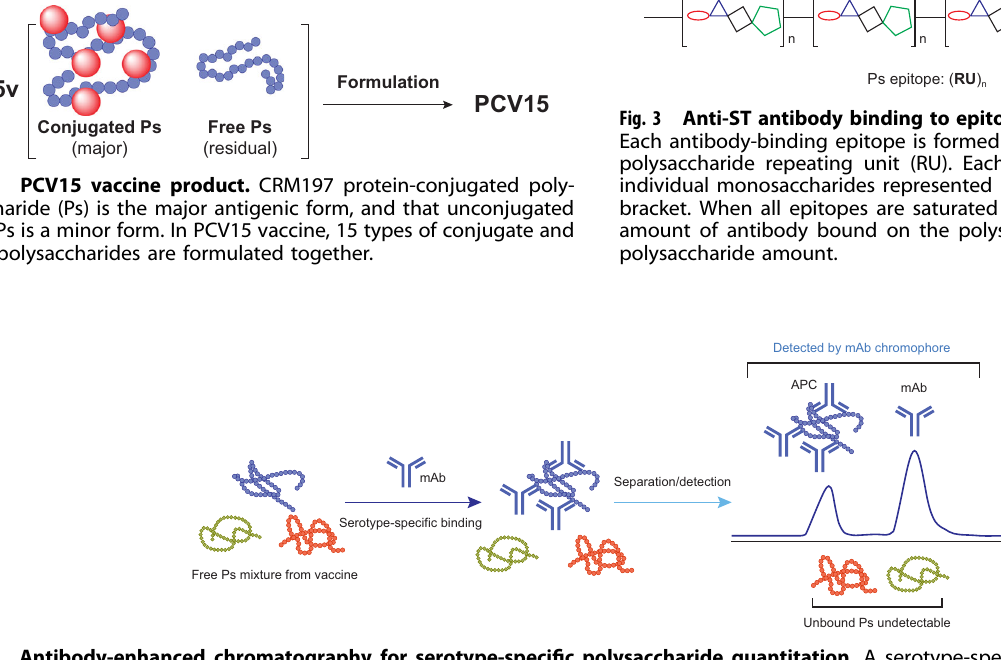
Fig. 2 Antibody-enhanced chromatography for serotype-speci fi c polysaccharide quantitation. A serotype-speci fi c antibody would only bind to its corresponding polysaccharide serotype in the vaccine. The resulting type-speci fi c antibody – polysaccharide complex is separated from excess antibody and used for polysaccharide quantitation.